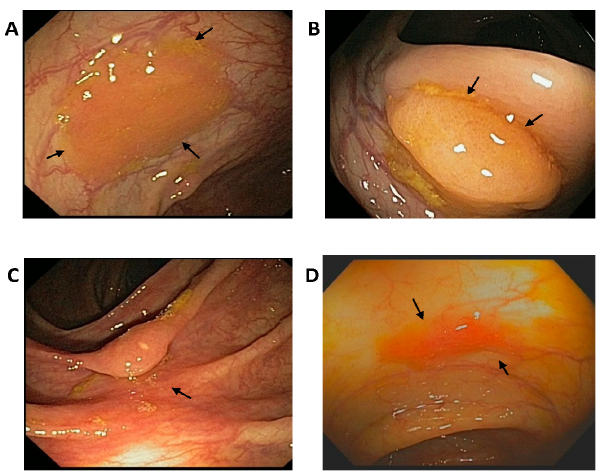
Figure 1. Endoscopic phenotype of four representative sessile serrated polyps/adenomas (SSA/Ps) located in the ascending colon of patients with the serrated polyposis syndrome. Panel A . Large 15 mm diameter SSA/P with a mucus cap. Panel B . 20 mm diameter SSA/P. Panel C. 10 mm diameter SSA/P. Panel D . Small 4 mm diameter SSA/P. The size of polyps was estimated using biopsy forceps as a reference. Histopathology analyses were consistent with SSA/Ps (M. Bronner).